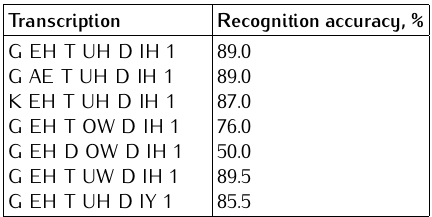
Table 4. Some of the accurately recognized word “Keturi” transcrip- tions, where one syllable was replaced with a more phonet- ically similar alternative